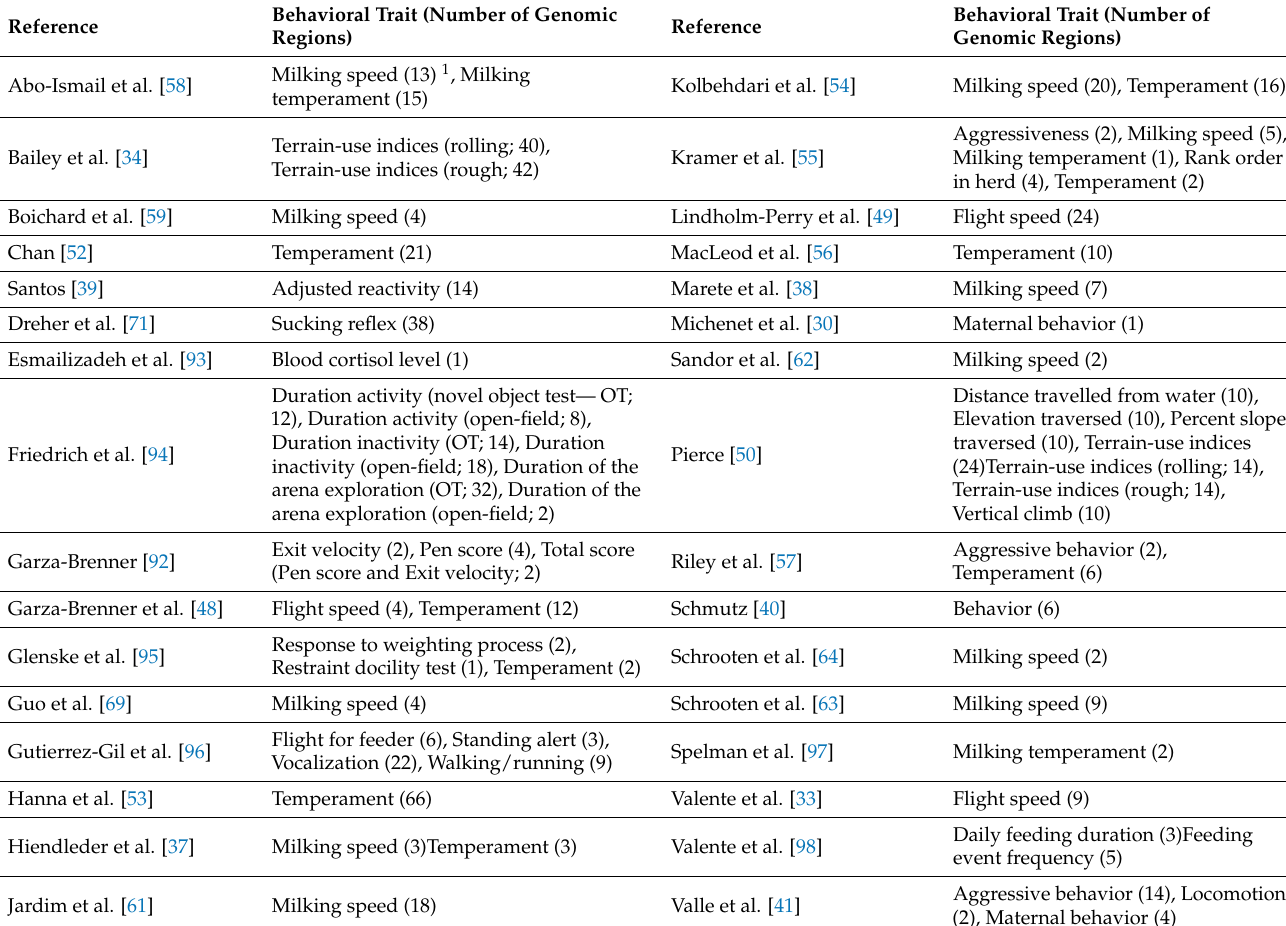
Table 2. References, behavior-related trait, and number of genomic regions gathered for beef and dairy cattle.